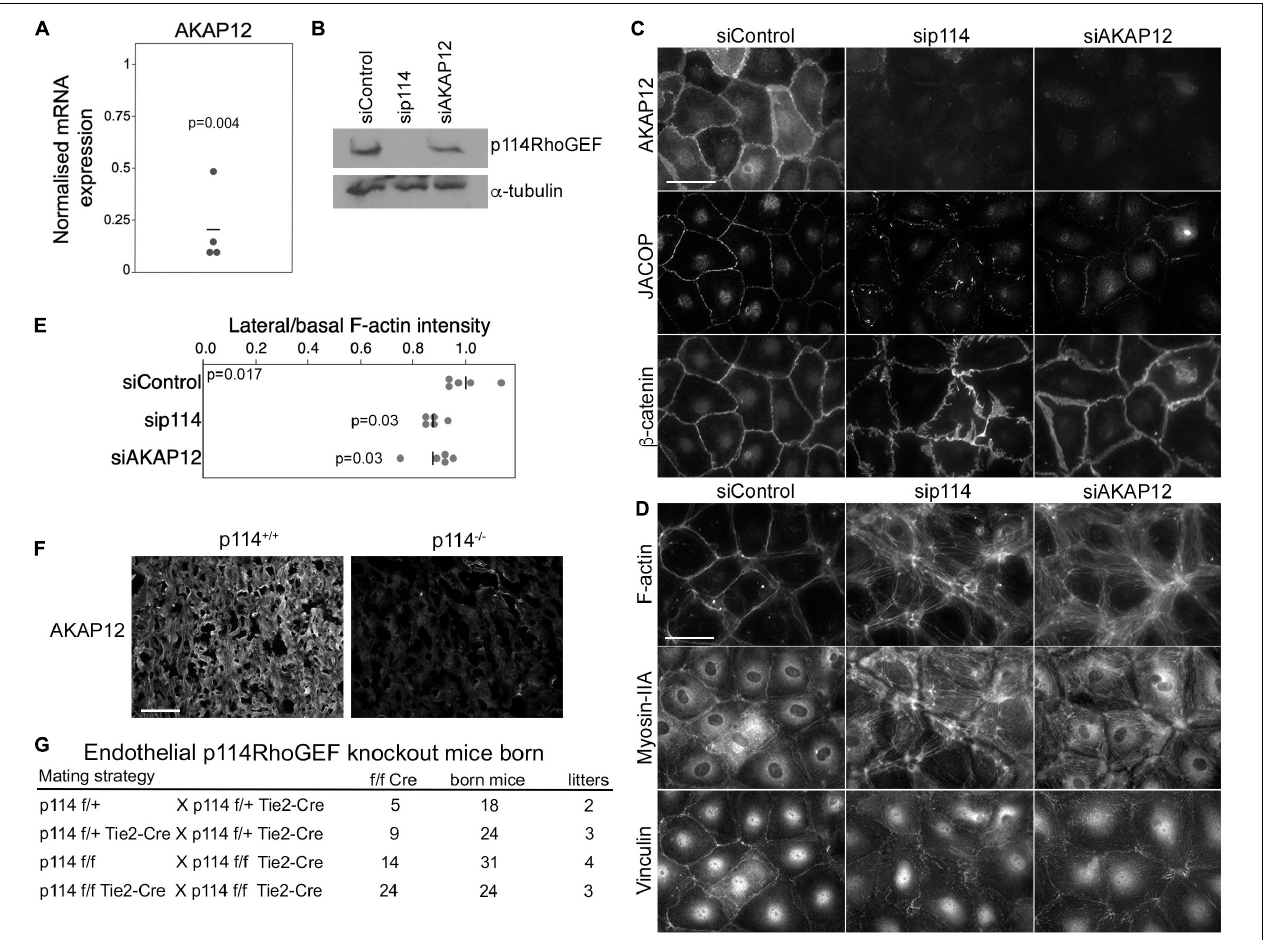
FIGURE 4 | p114RhoGEF depletion suppresses AKAP12 expression in endothelial cells and placentas but endothelial specific deletion does not affect embryonic viability. (A) p114RhoGEF depletion represses expression of AKAP12 mRNA as assessed by RT-qPCR. Data were normalized to wild type controls in each litter. Shown are data points derived from different placentas, means and p-values derived from t -tests. (B–E) HDMECs were transfected with siRNAs as indicated and then processed for (B) immunoblotting or (C,D) immunofluorescence for the indicated markers. Note, AKAP12 depletion induces a strong reorganization of the actin cytoskeleton and reduced JACOP expression reminiscent of the effect of p114RhoGEF depletion. Expression of p114RhoGEF was quantified and calculated as a ration to α -tubulin expression (C) . Redistribution of F-actin was quantified by calculating ratios of lateral vs. basal F-actin intensity ( p -values are derived from ANOVA and Tukey HSD tests). (F) AKAP12 staining in cryosections of placentas from wild type and p114RhoGEF deficient mice. Note the strong repression of AKAP12 expression by p114RhoGEF depletion in vitro and in vivo . (G) Analysis of litter genotypes derived from inter-crossing mice harboring the conditional